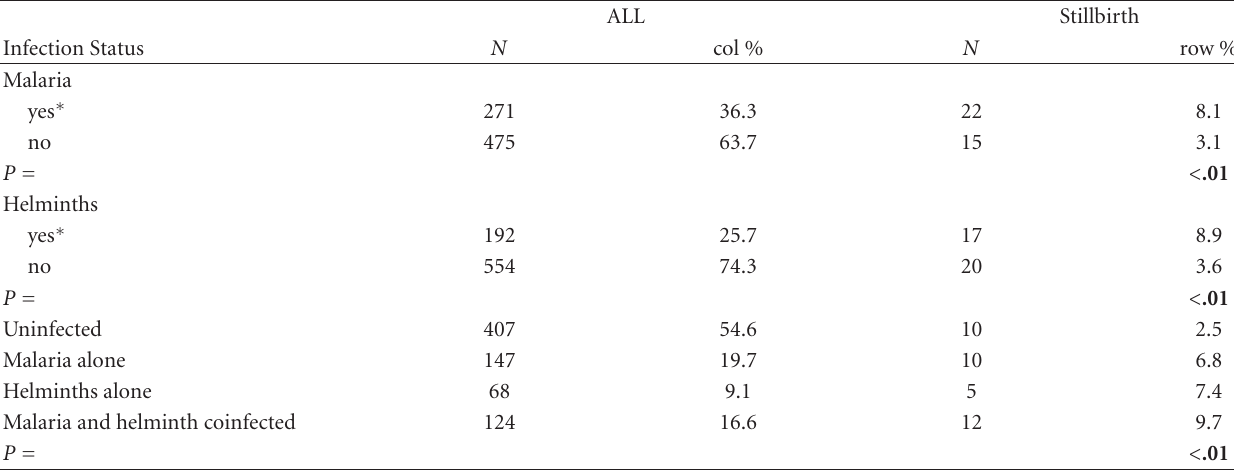
Table 2: Malaria and intestinal helminth infection status of 746 Ghanaian women according to whether or not they had stillbirths, 2006.